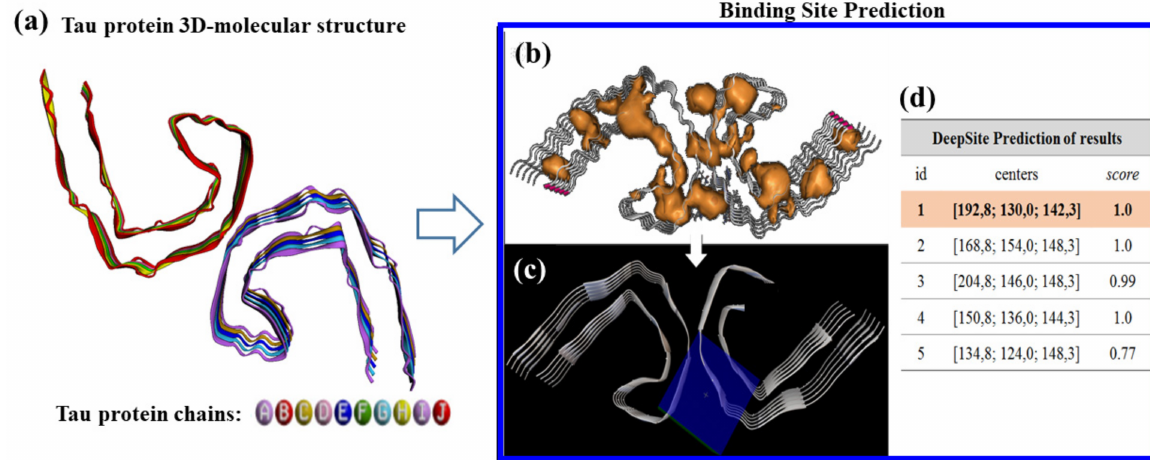
Figure 2. ( a ) Representation of three-dimensional structure of tau protein with the corresponding chains. ( b ) Representation of the predicted binding sites for tau protein. ( c ) Representation of the docking box simulation set for the most probable binding site of tau protein according with the maximum score in the DeepSite. ( d ) Table of results of the coordinates value obtained for the grid-box centers for the predicted binding sites highlighting the best ranked-binding site ID: 1. A ranking-based on the volume (V) in Å 3 for each predicted tau-protein binding site is reported like: site ID 1: V = 827.02 Å 3 , site ID 2: V = 465.15 Å 3 , site ID 3: V = 464.15 Å 3 , site ID 4: V = 359.15 Å 3 , site ID 5: V = 329.95 Å 3 . In order to establish the relevance of each binding site of tau protein. It is well-known that the pocket cavity volume has a linear-correlation with the binding-site surface area, maximum intrinsic affinity of the ligand and its “druggability” or ability to strongly interact with a given binding site. More structural details can be found in Supplementary Materials as Figure S1.